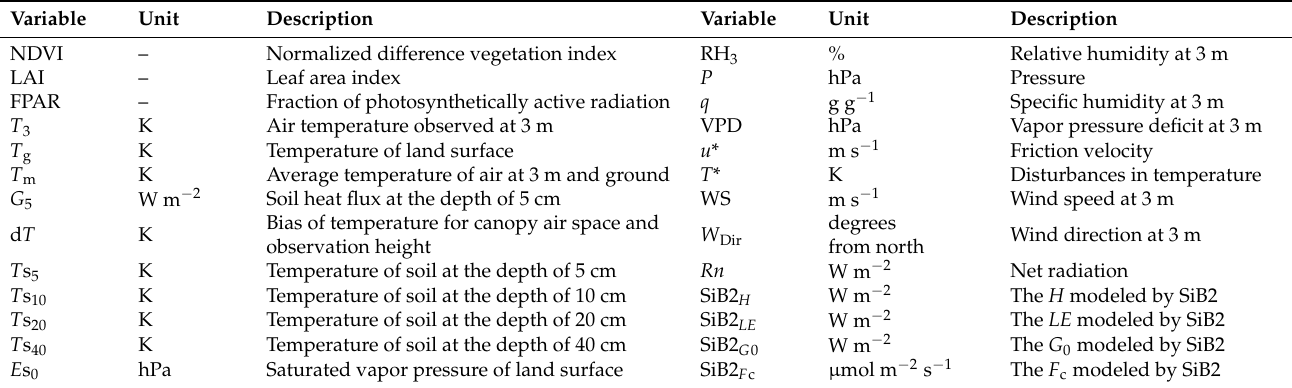
Table A2. Variables selected to train the RF